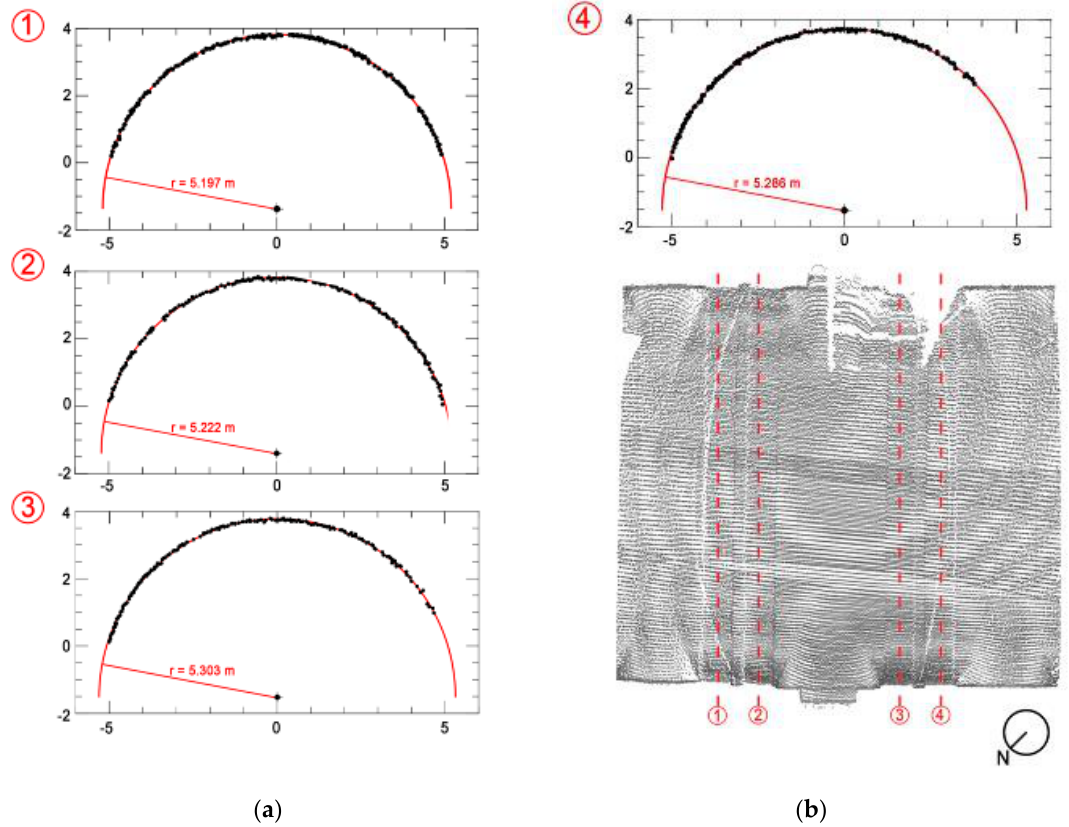
Figure 4. Church of St. Marta: identification of geometric shape of the twin arches by least square minimization procedure: ( a ) four transversal sections of the arches extracted from the point cloud and ( b ) localization in a plan view of the extractions.